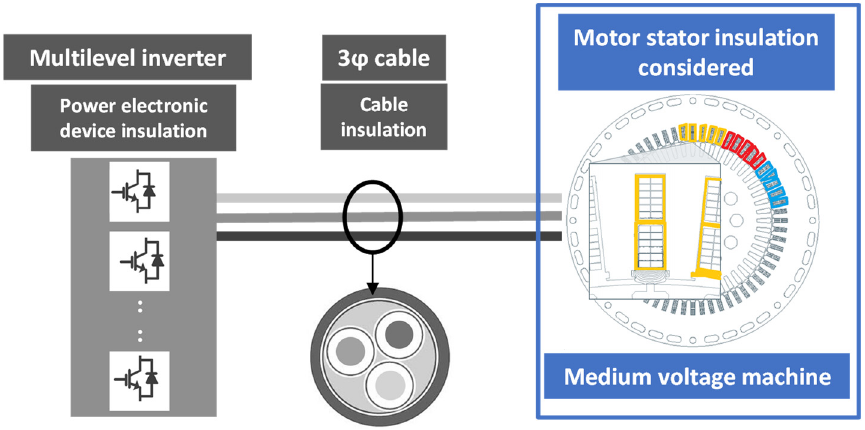
Figure 1. Medium-voltage machine drive with stator ground-wall insulation considered.